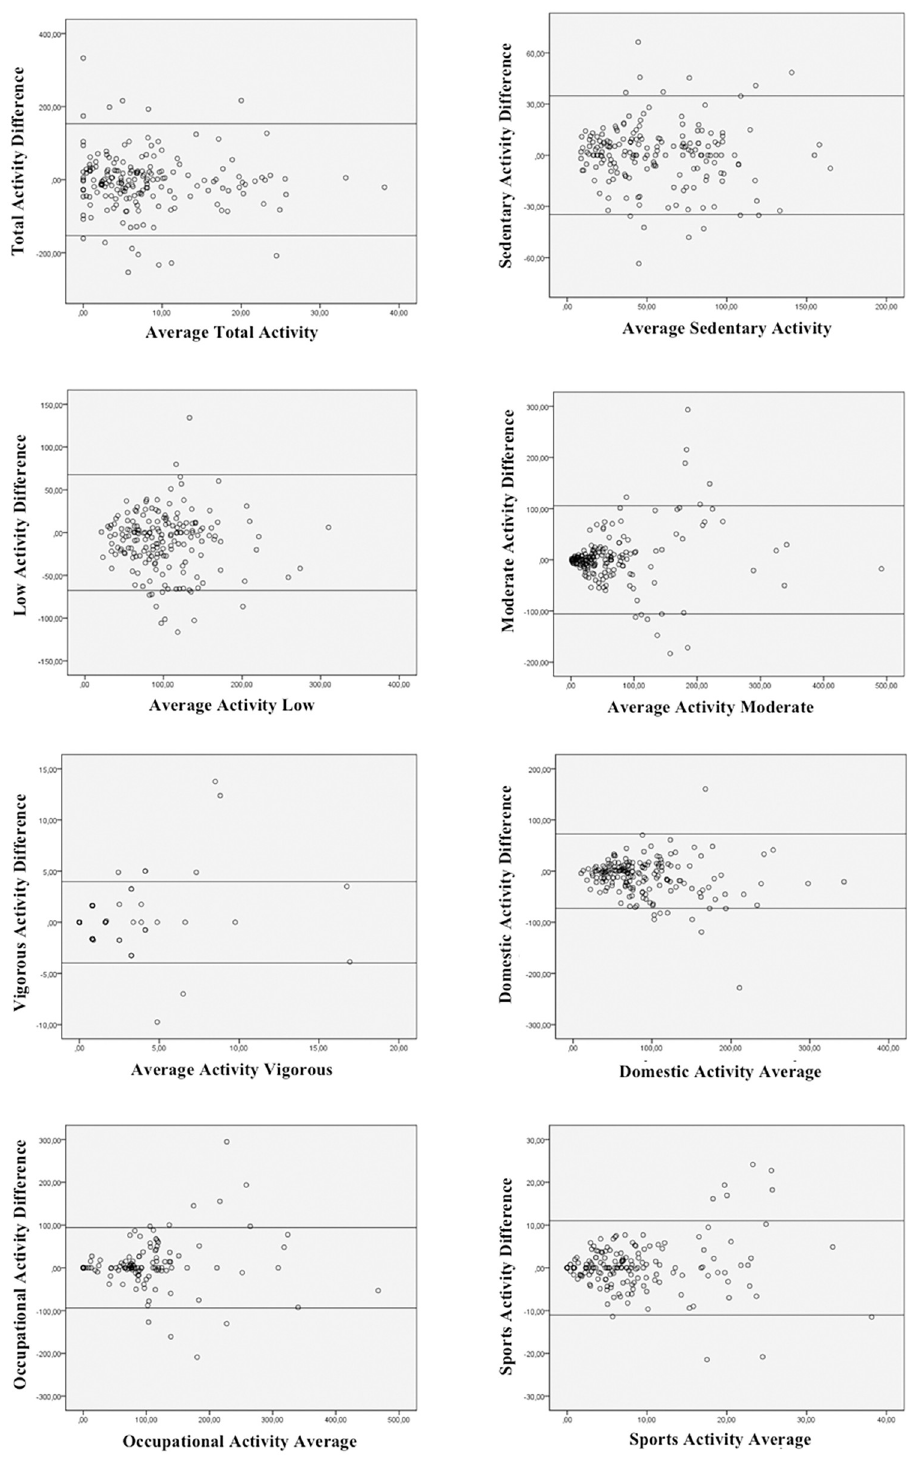
Fig 2. Dispersion graphs (Bland-Altman) for the results obtained by the PPAQ1 and PPAQ2, according to the intensity and type of physical activity.